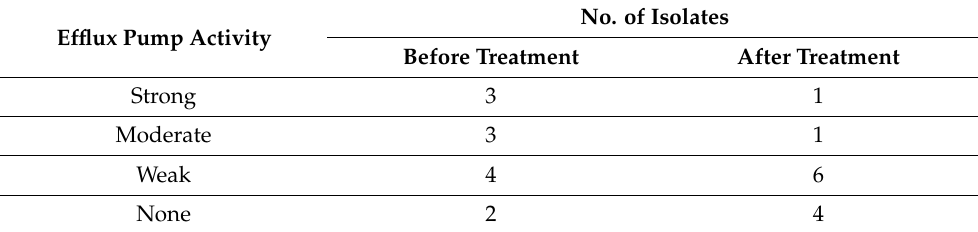
Table 2. Impact of EVME on efflux pump activity of C. glabrata isolates.